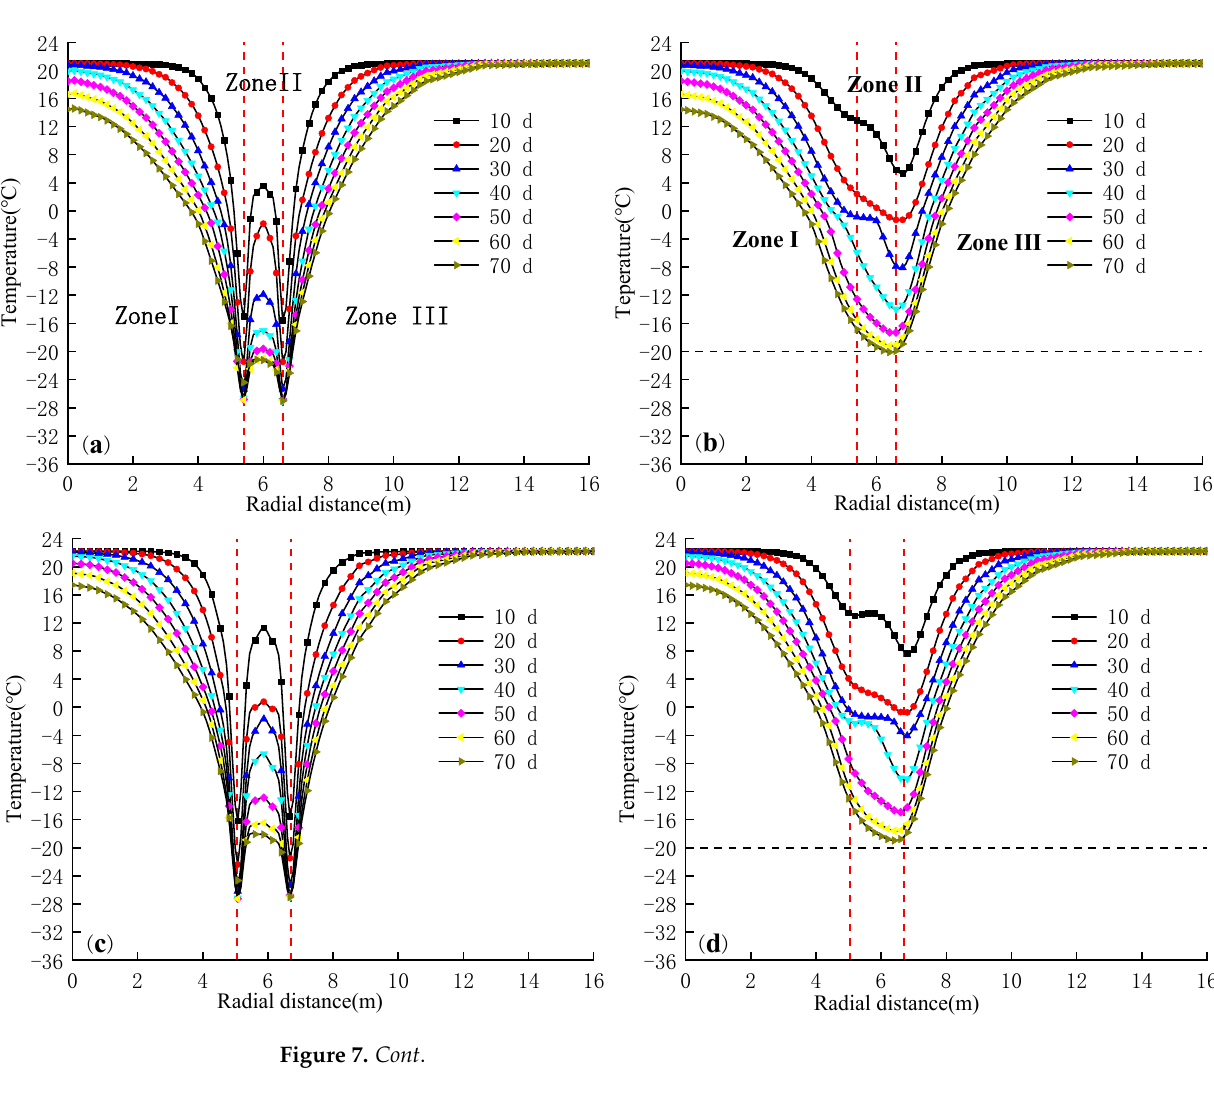
Figure 7. Temperature field distribution at the main surface and interface. ( a ) The − 120.5 m fine sand main surface. ( b ) The − 120.5 m fine sand interface. ( c ) The − 190 m clay main surface. ( d ) The − 190 m clay interface. ( e ) The − 216 m sandy clay main surface. ( f ) The − 216 m sandy clay interface. 3.3.4. Influence of Brine Temperature on Temperature Field of Frozen Wall The temperature of circulating cooling agent (brine) governs the formation of frozen wall. Here, − 216 m sandy clay layer control is taken as the research object, and based on the actual position of the freezing holes, the active freezing period under different brine temperatures as well as the variations in the characteristic parameters of the temperature field of the frozen wall (effective frozen wall average temperature, effective thickness of frozen wall) with time are examined. The brine temperature in the active freezing period is − 20, − 25, − 30, and − 35 °C. It is assumed that the on-site circulating brine temperature for the first 19 d is the same as that in the actual project, and the brine temperature of the freezing holes remains unchanged after the 20th day of brine circulation. As shown in Figures 8 and 9, the variation in the brine temperature during the active freezing period affects the average temperature and thickness. Under the same freezing time, the lower the brine temperature, the lower the effective frozen wall temperature and the greater the thickness. When frozen for 130 d, the brine temperature decreases from − 20 and − 35 °C, and the average temperature of e ff ective frozen wall decreases from − 12.16 to − 21.09 °C, corresponding to a decrease of 73.4%. Under freezing for 130 d, the effective frozen wall thickness increases from 4.05 m to 4.65 m, which corresponds to an increase of 14.8%. For the sandy clay layer at the control horizon of topsoil ( − 216 m), during excavation (frozen